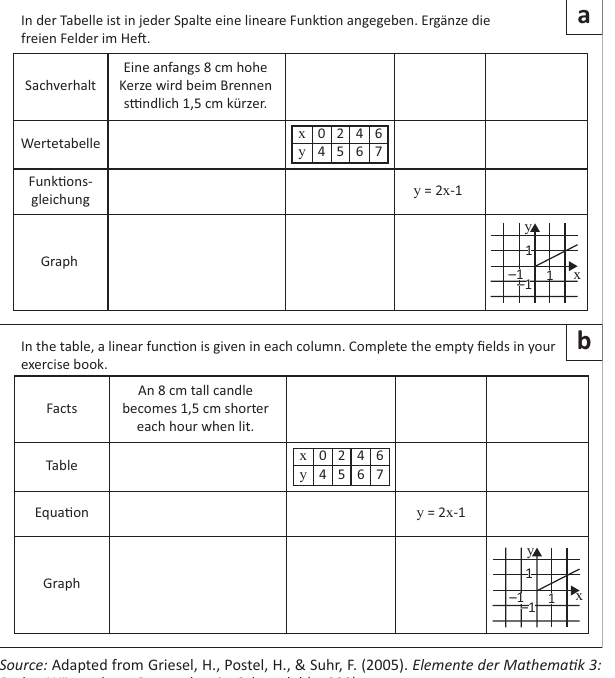
FIGURE 8: Task from Elemente der Mathematik 3 on isosceles triangles, (b) translation of the task.